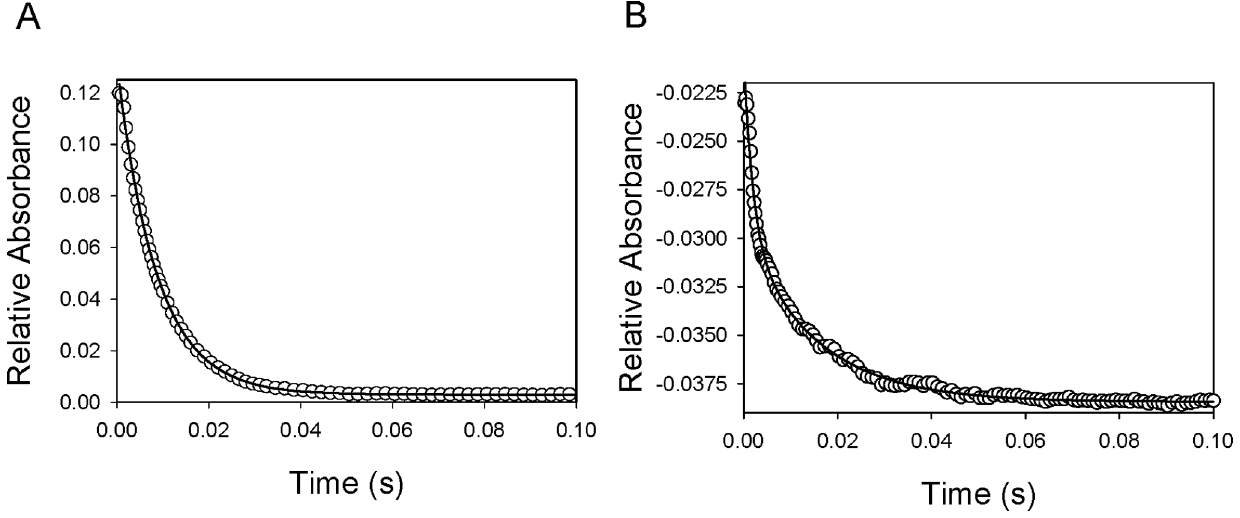
Figure 5. Stopped-flow kinetics of CO ligand association with HbA in the presence and absence of Hp. A. Representative time course of CO (500 m M after mixing) binding with HbA was fitted to single exponential equation by non-linear least squares regression analysis. B. Representative time course of CO (250 m M after mixing) binding with the HbA and Hp complex was biphasic, and fitted to double exponentials to derive apparent association rate constants.